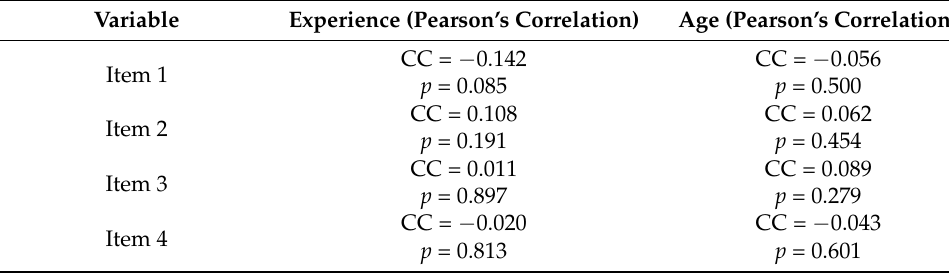
Table 4. Correlation between research items, experience, and